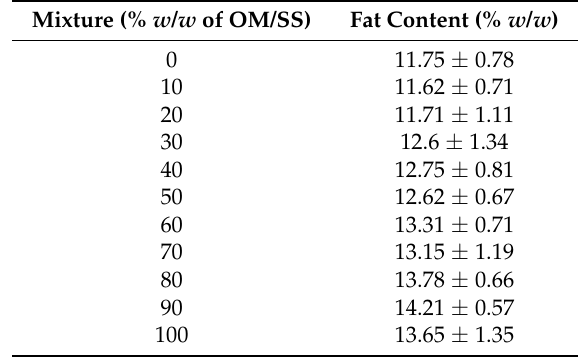
Table 2. Fat content of Salmo salar (SS) and Onconrhynchus mykiss (OM) samples in (% w / w ).